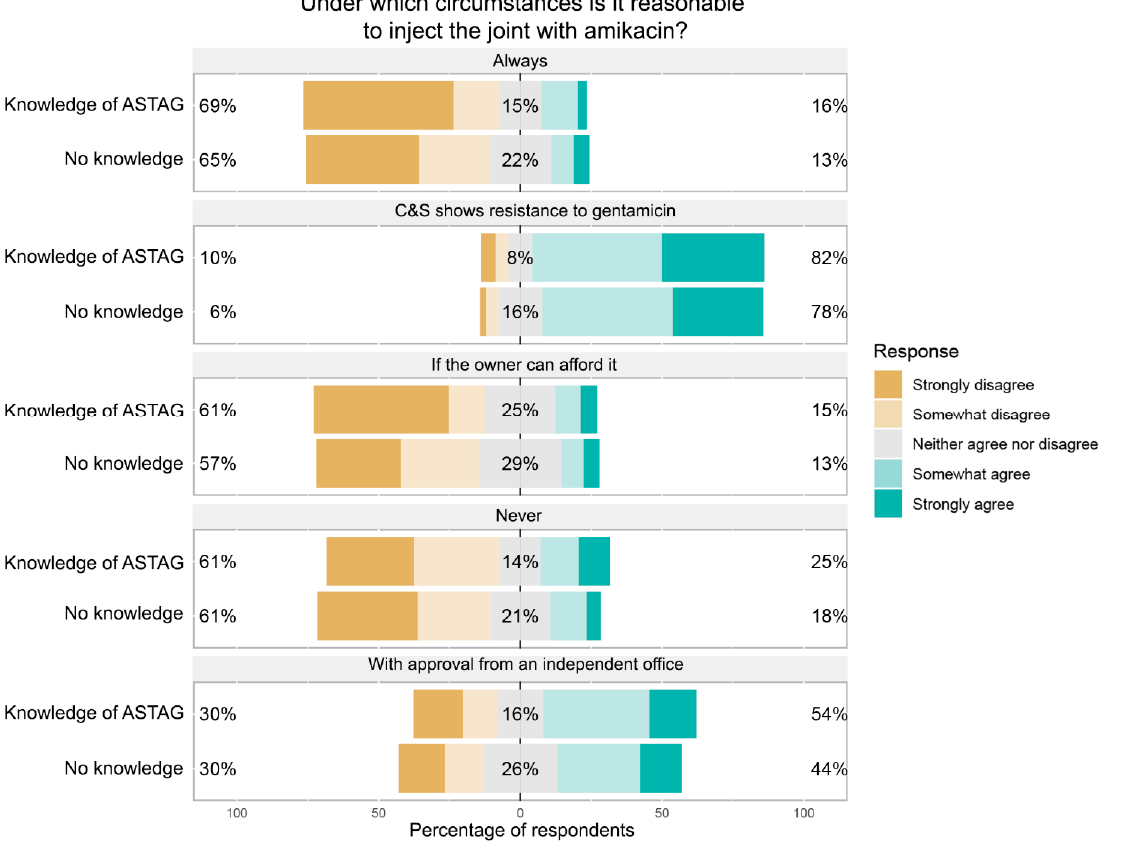
Figure 5. Responses of participants regarding reasonableness of injecting a horse’s fetlock with amikacin in different circumstances, with responses segregated based on the respondents’ knowledge of the ASTAG rating system.